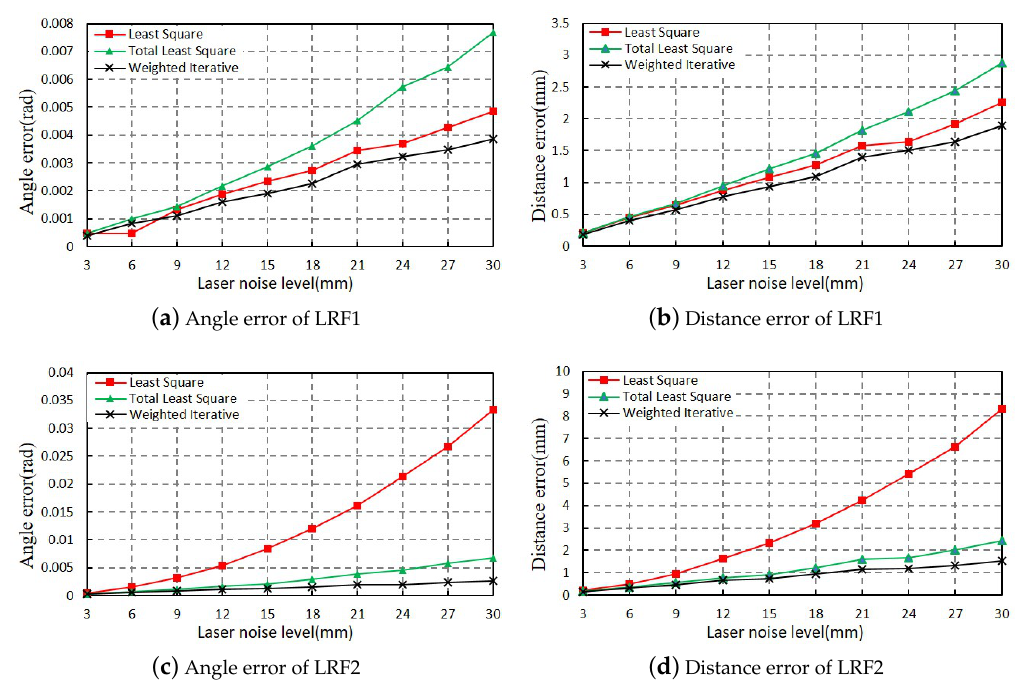
Figure 6. Linear fitting errors of two LRFs using three methods. Panels ( a , b ), respectively, represent the angle and distance error of the linear fitting parameters of LRF1, and panels ( c , d ), respectively, represent the angle error and distance error of the linear fitting parameters of